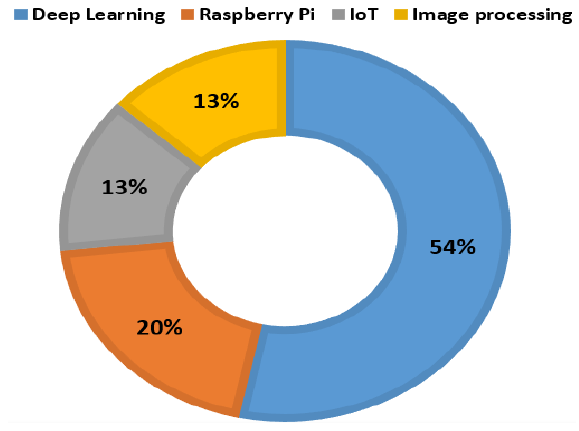
Figure 2. Related Literature